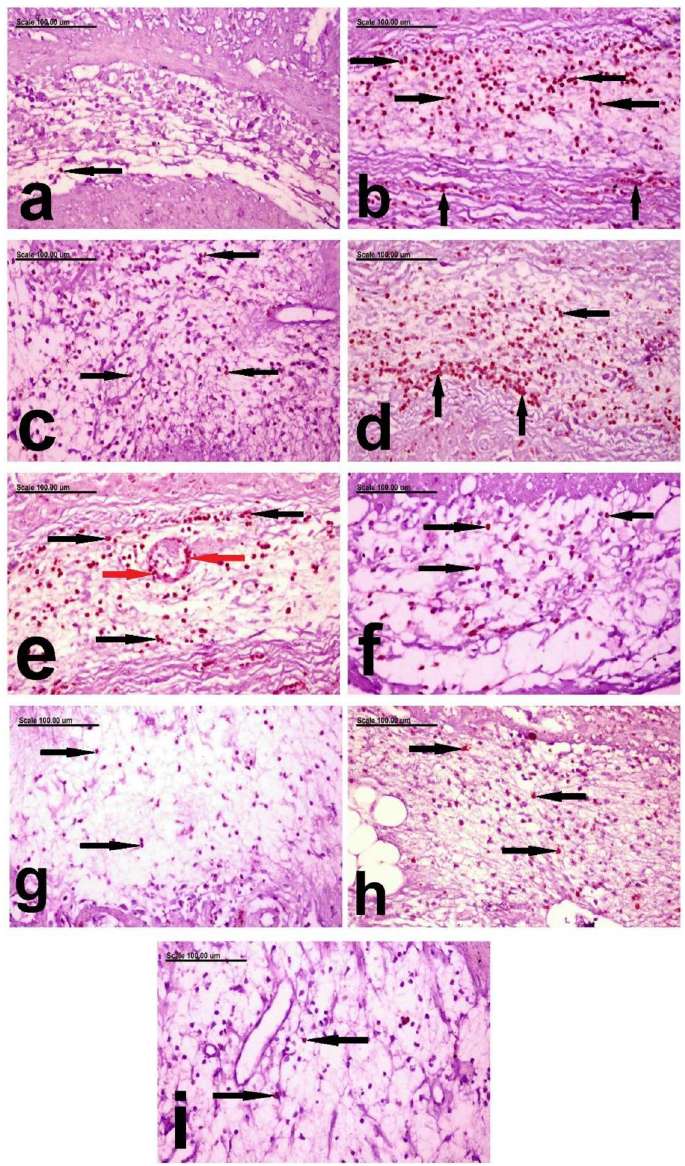
Figure 9. Photomicrograph showing the distribution of MPO-positive cells in the colonic sub-mucosa photomicrograph from the MPO immunohistochemically-colon submucosa of, ( a ) negative control rats showing Individual brown stained MPO+ cells (arrow) in the mucosa, ( b ) C+ ve rats showing numerous intensely brown stained MPO+ cells in the colonic submucosa and T.muscularis (arrows), ( c ) Prednisolone treated group showing significant decrease of brown stained MPO+ cells (arrows), ( d ) the low dose leave group showing abundant brown stained MPO+ cells (arrows), ( e ) the high dose leave group showing brown stained MPO+ cells in the wall of the submucosal blood vessel (red arrows) and the submucosa (black arrows), ( f ) low stem-treated groups showing marked decrease of % of MPO+ cells (arrows), ( g ) high dose stem-treated groups showing remarkable decrease of % of MPO+ cells (arrows), ( h ) low dose fruit peels treated group showing significant decrease of MPO+ cells with brown staining (arrows), and ( i ) high dose fruit peels treated groups showing few scattered MPO+ cells (arrows). (MPO immunohistochemical staining; Scale bar = 100